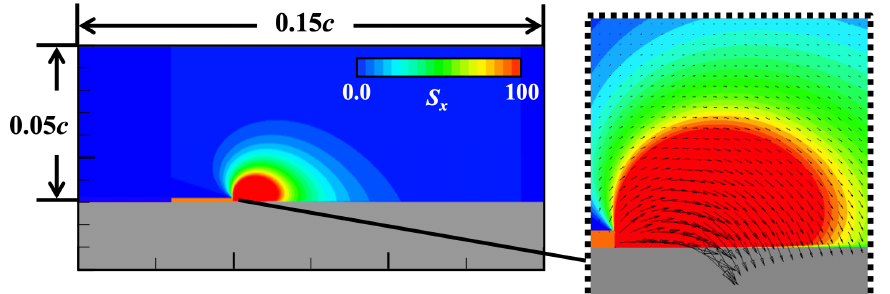
Figure 5. Distribution of body force in the x direction based on the Suzen–Huang model [31] and body force vectors near the actuator. Gray and orange areas represent the airfoil surface and exposed electrode,